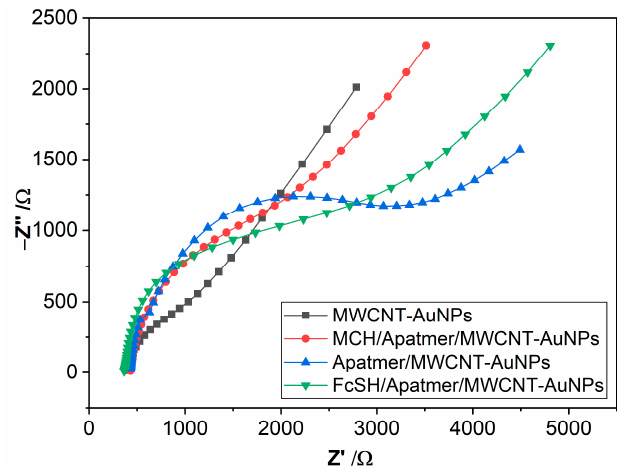
Figure 3. EIS measurements for non-immobilized MWCNT compared with immobilized MWCNT- AuNPs, MCH/aptamer/MWCNT/AuNP and FcSH blocking agent with the equivalent Randles cir- cuit s for the measured electrode. Table 1. Equivalent circuit parameters i.e., R ct and C dl for the measured